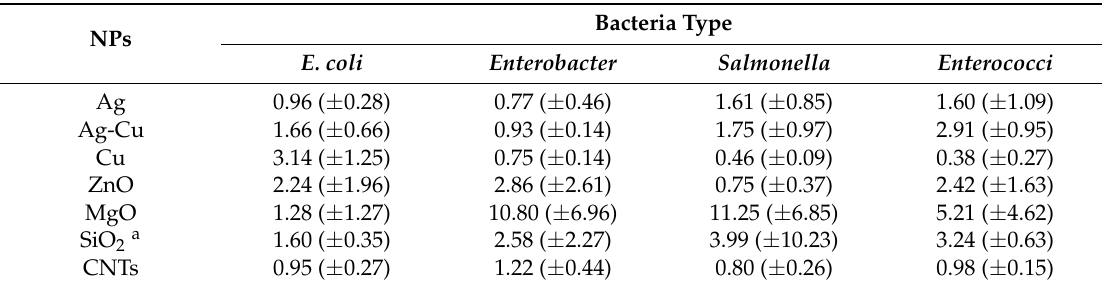
Table 10. Average ratio of log inactivation in MSF water relative to that in RO water (n = 4). Values in parentheses represent the 90% confidence